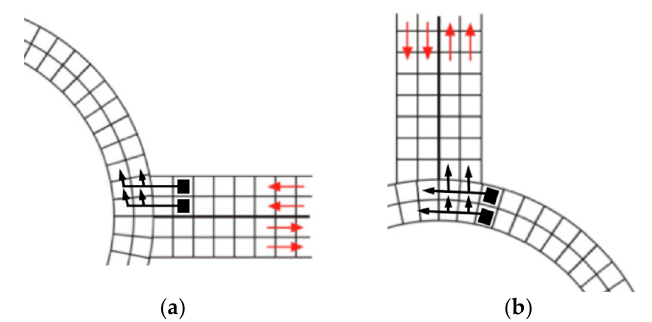
Figure 2. Scenario 1: possible directions of vehicle movement in the roundabout ( a ) enter; ( b ) exit.